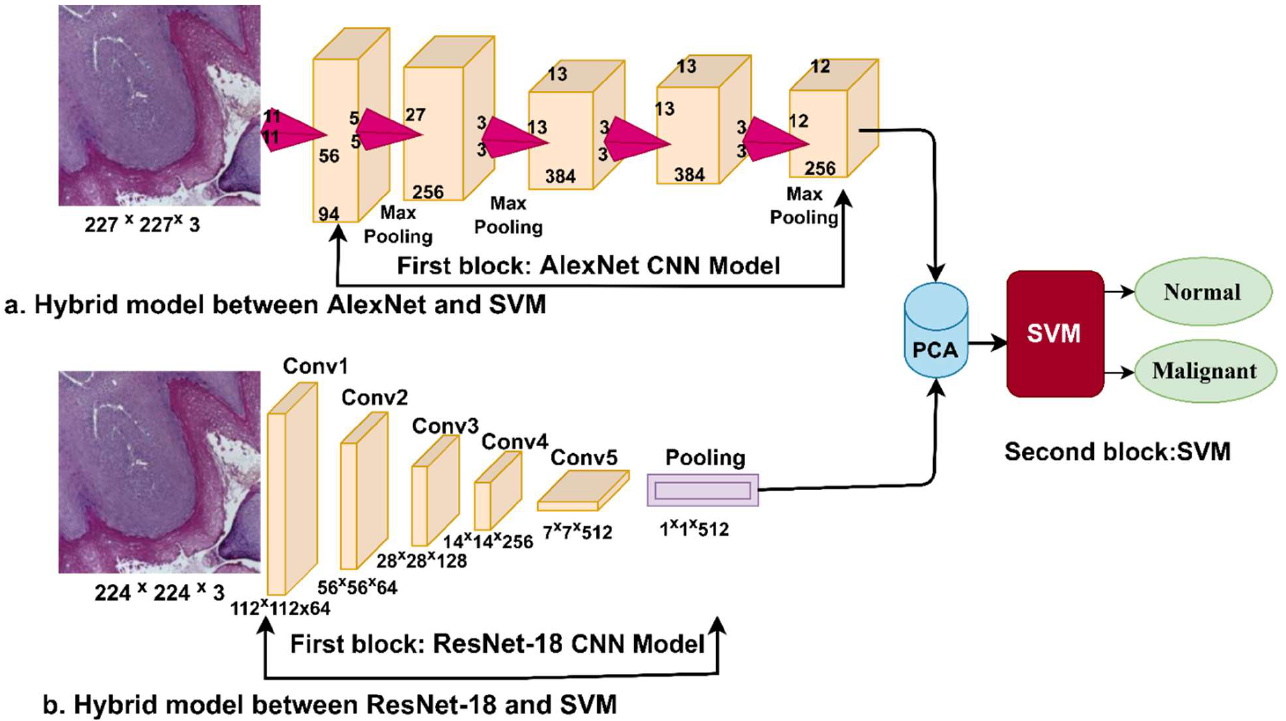
Figure 3. Methodology for histopathological image diagnosis of oral cancer by a hybrid technique between CNN and SVM